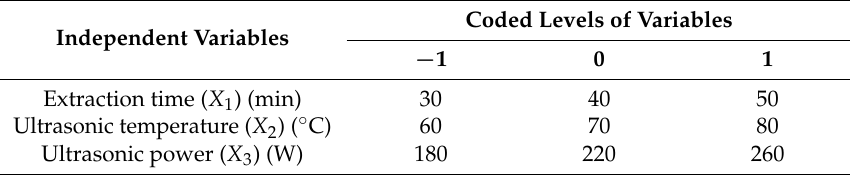
Table 4. Independent variables and their levels used for Box-Behnken design